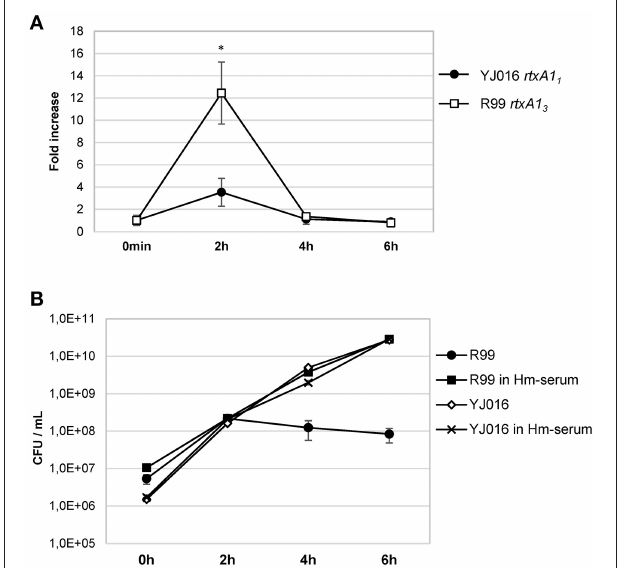
FIGURE 9 | rtxA1 expression in the presence of human blood cells. (A) Expression by Real time qPCR of rtxA1 1 and rtxA1 3 in YJ016 and R99 strains, respectively. Bacteria were incubated for 0, 2, 4, and 6 h in commercial human serum supplemented with Fe (Hm-serum) plus human PBMCs. The value of expression of each gene in the 0 h sample was set equal to 1, and the fold-change in gene expression was calculated in 2, 4, and 6 h samples. (B) Bacterial growth in commercial human serum with (Hm-serum) or without supplemented Fe. (A, B) Data represent mean values ± standard deviation from two independent experiments. The significance of the differences was determined using Student’s two-tailed t -test; * p < 0.05 compared with values at time